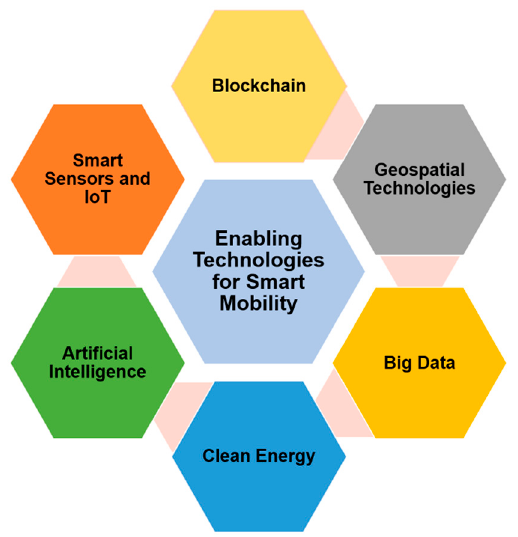
Figure 9. Enabling technologies to support smart